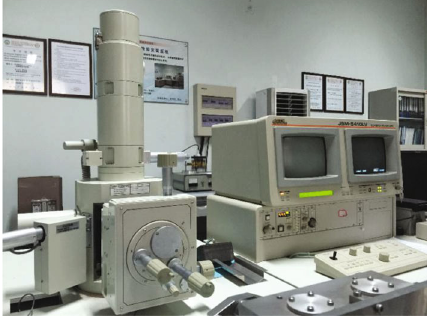
Figure 4: JSM-5410V Scanning Electron Microscopy (SEM).